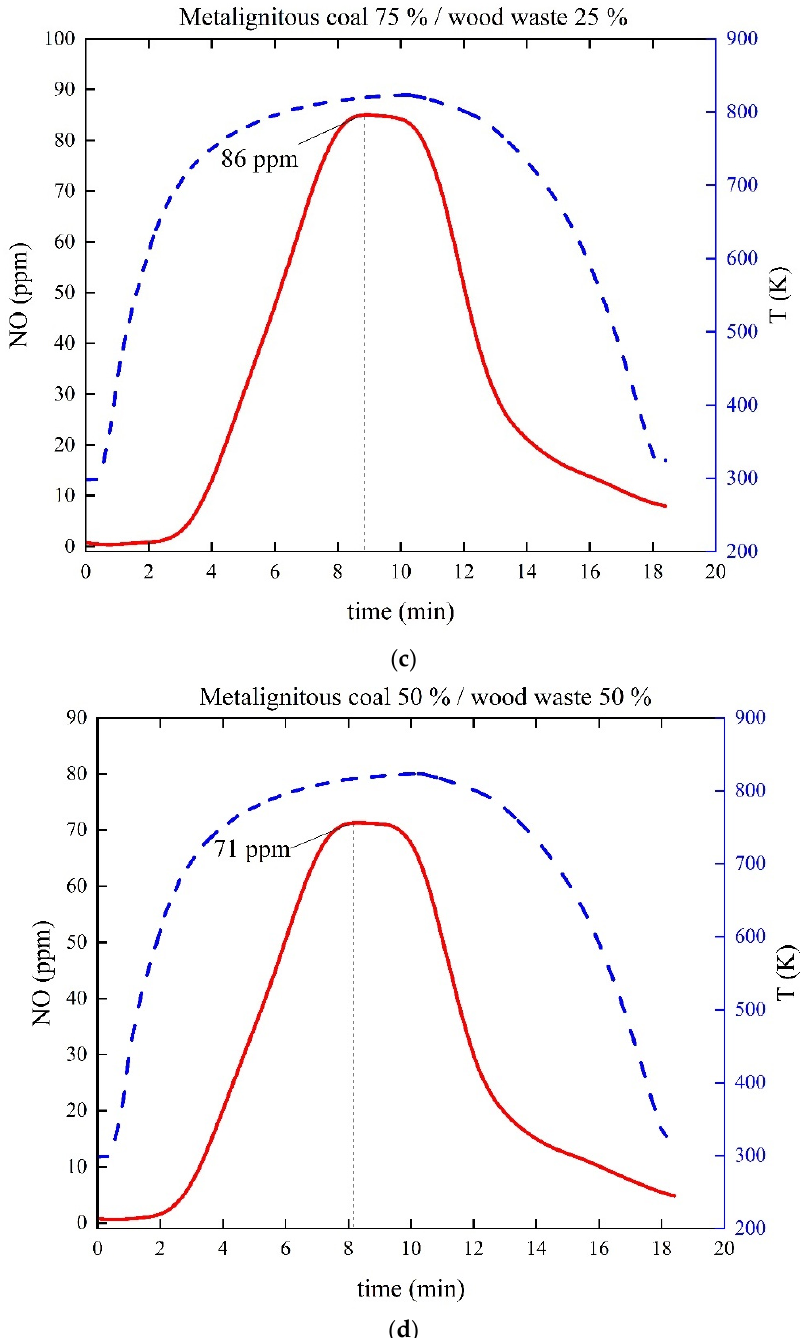
Figure 3. Changes in the concentration of nitrogen oxides in the gaseous products of thermal de- composition of mixed fuels based on D-grade coal and wood with a change in the proportion of the latter in the mixture from 10% to 50%: ( a ) metalignitous coal 100%; ( b ) metalignitous coal 90%/wood waste 10%; ( c ) metalignitous coal 75%/wood waste 25%; ( d ) metalignitous coal 50%/wood waste